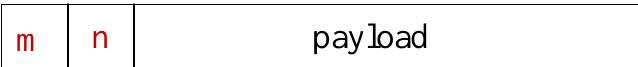
Figure 8. Packet format considered in the proposed